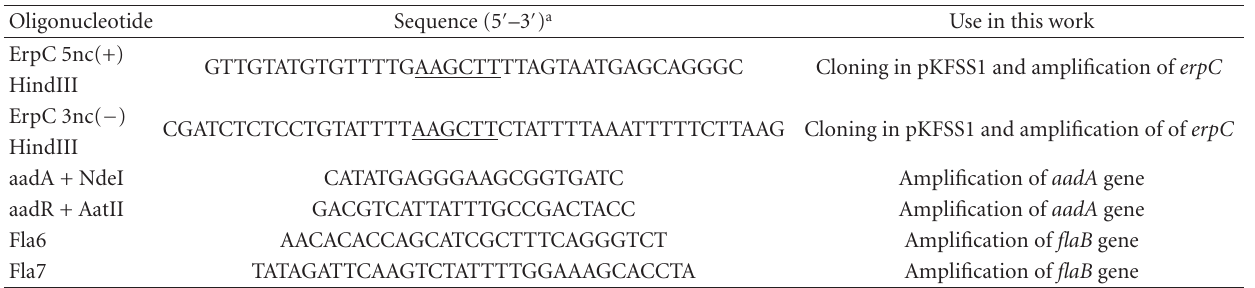
Table 1: Oligonucleotides used in this